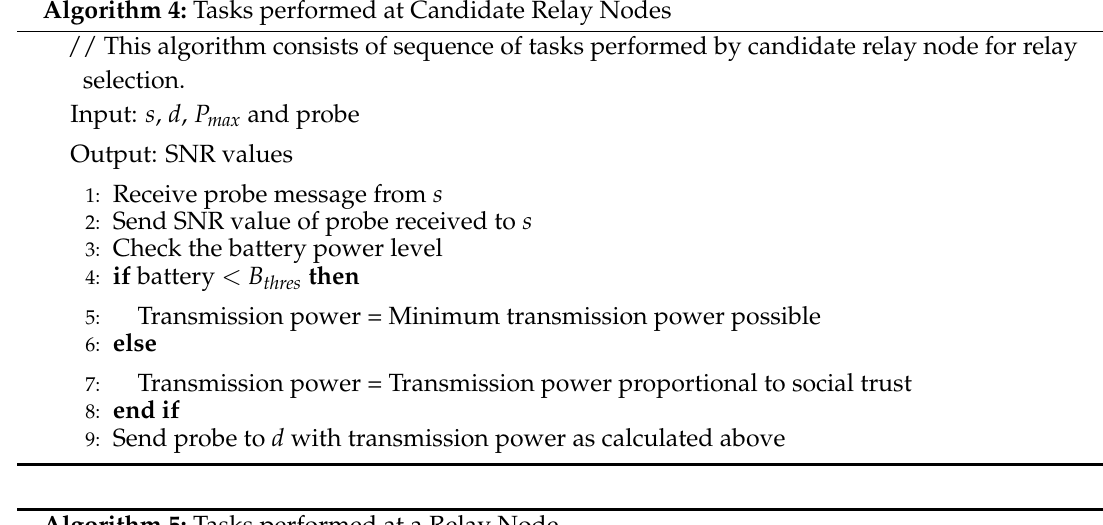
Algorithm 5: Tasks performed at a Relay Node // This algorithm consists of sequence of tasks performed by a relay node in D2D communications.